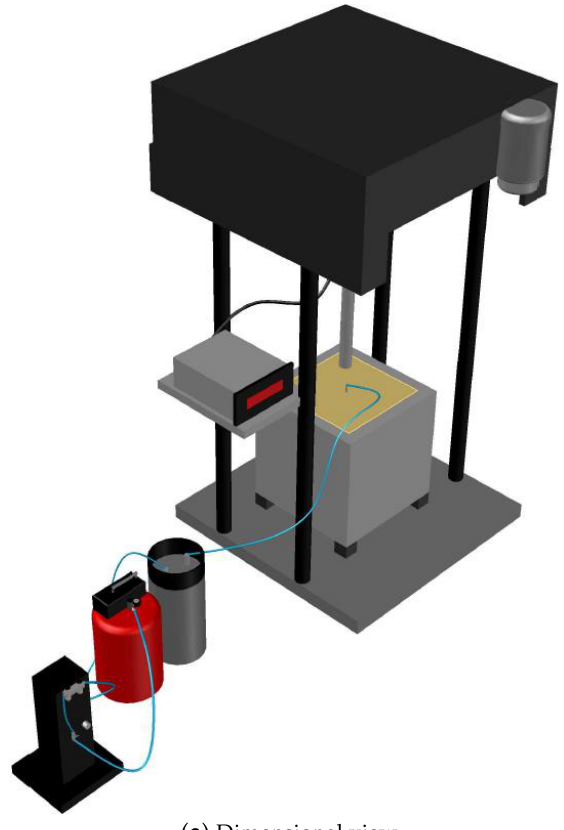
Figure 3. Consolidation test.